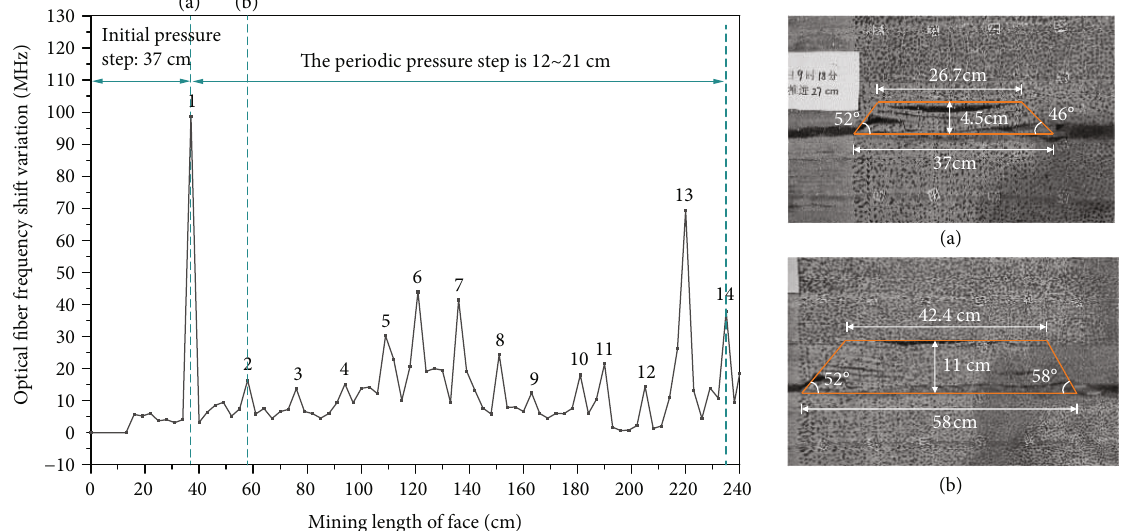
Figure 8: Impact pressure identi fi cation curves during the mining of coal seam 1 -2 (the abscissa is the face excavation distance, and the ordinate is the variation degree of the optical fi ber frequency shift). (a) Face excavation distance of 37cm. (b) Face excavation distance of